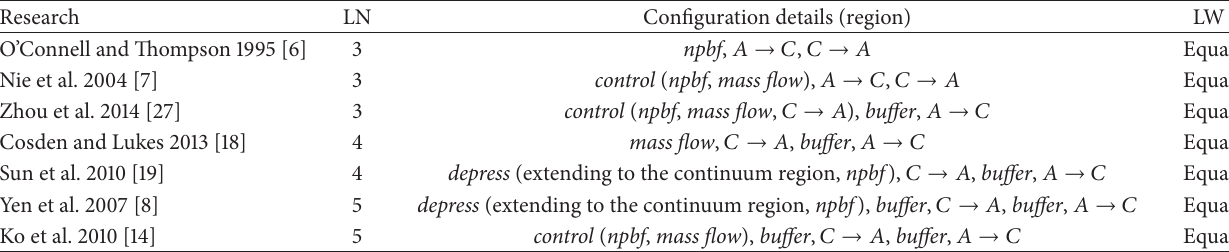
Table 1: Configurations of functional regions in the overlap